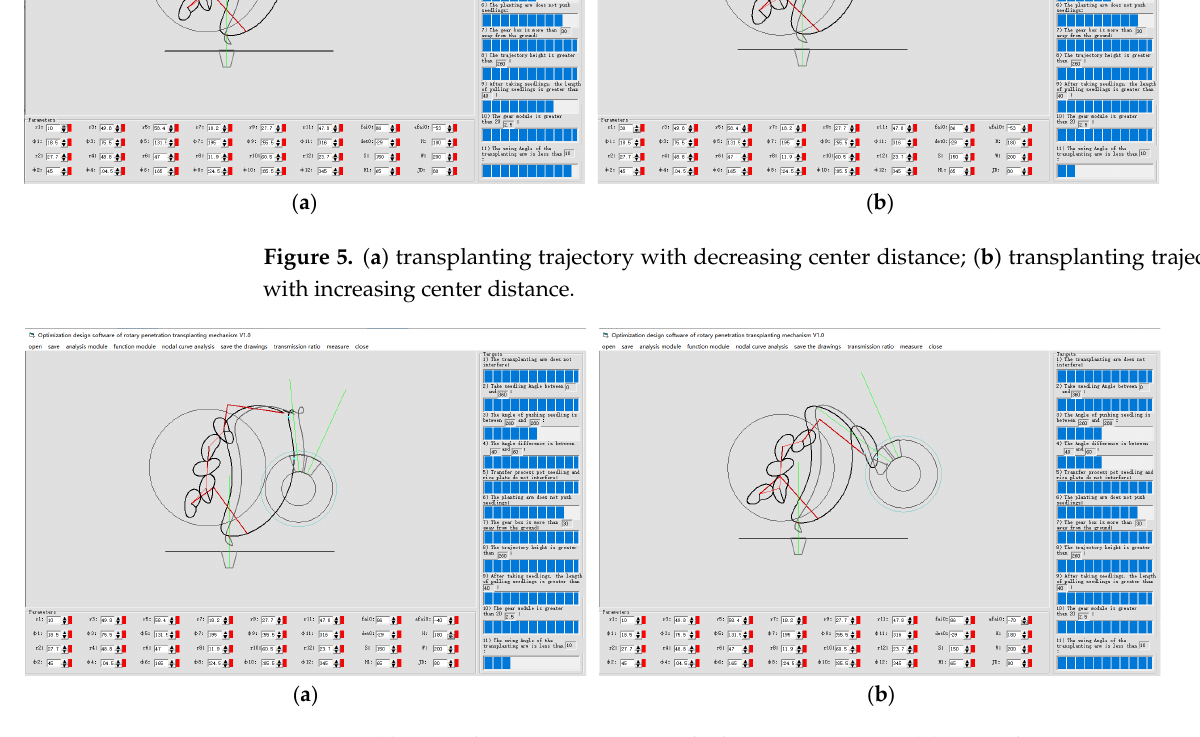
Figure 7. Processing tool drawings.